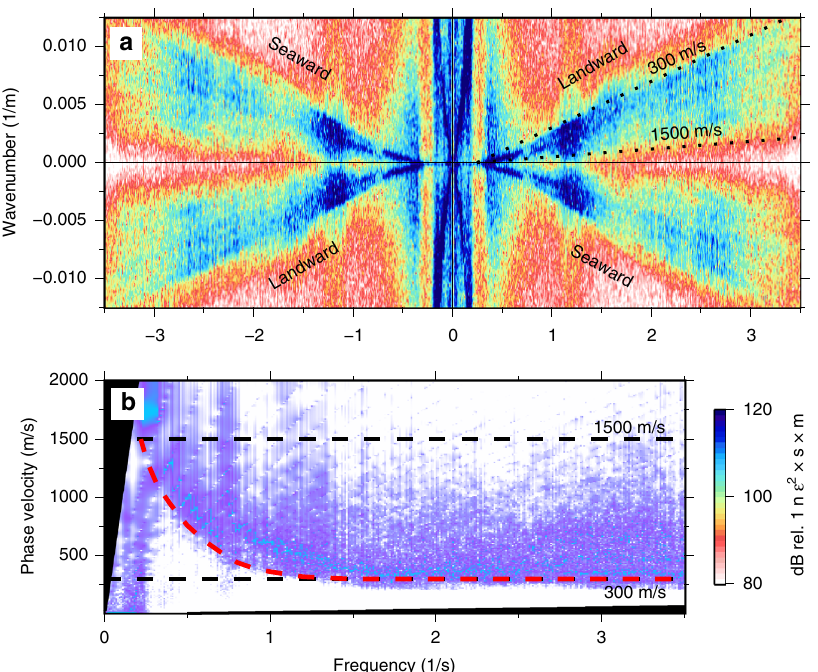
Fig. 5 Scholte (seismic) waves. a Raw distributed acoustic sensing frequency – wavenumber ( f - k ) spectrum calculated over 1 h between 35 and 40 km, showing symmetric landward- and seaward-propagating Scholte waves between 0.3 and 3.5 Hz. b The f - k spectrum from quadrant 1 of a projected into phase velocity space showing coherent dispersion from (cid:1) 1500 m/s at 0.36 Hz to (cid:1) 300 m/s above 1 Hz (each frequency bin is normalized). Both a and b are overlaid with contours of constant velocity at 1500 and 300 m/s (black), and an approximate dispersion curve is hand-drawn in b